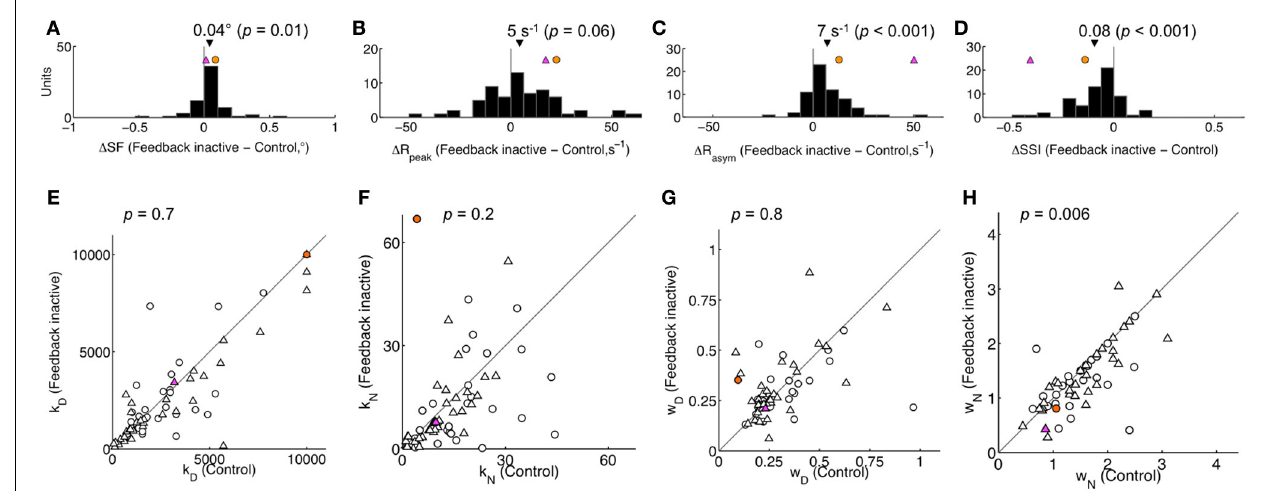
FIGURE 3 | Population effect of feedback inactivation on high contrast area summation. (A–D) Summation curve features: difference in summation field (SF), peak response rate ( R peak ), asymptote response rate ( R asym ), and surround suppression index (SSI) between feedback inactive and control conditions. Black triangle indicates population mean (with two-tailed t -test p -value). (E–H) Parameter estimates ( k D , k N , w D , w N ) for all units plotted for Feedback inactive vs. Control conditions. p -values correspond to a two-tailed